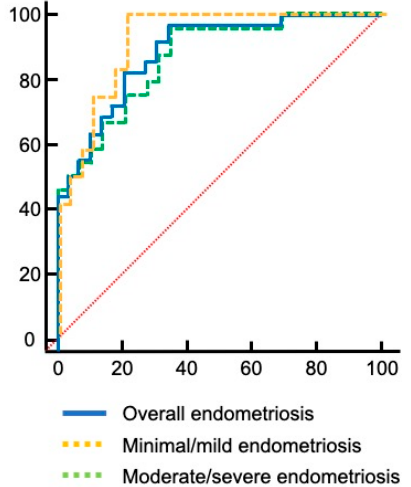
Figure 2. The accuracy of BIRC5 expression in the peripheral blood for the diagnosis of endometriosis. Red dotted line indicates line of no-discrimination.